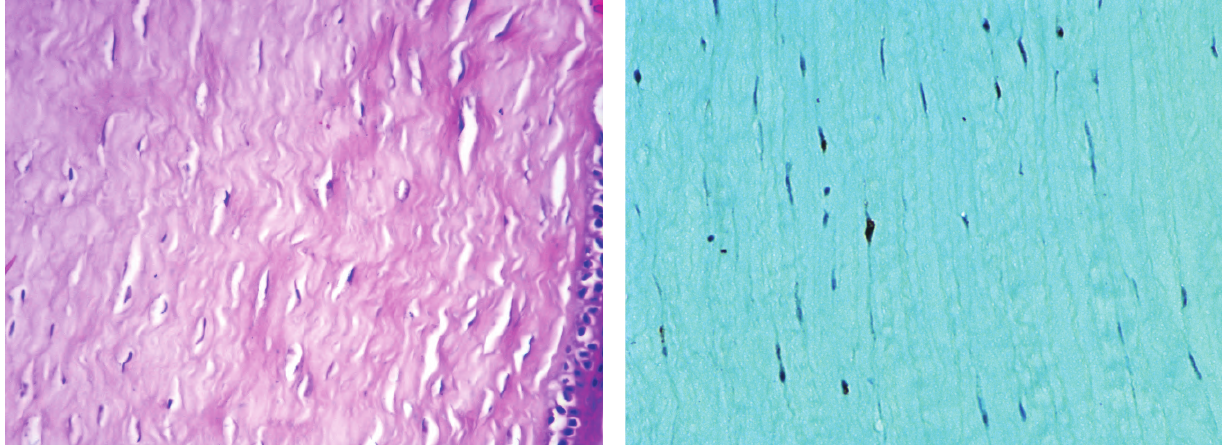
Figure 3. (a) A section of cornea from control group (HE X 400). (b) Positively stained nuclei in a section from ZX group (Caspase X 400).